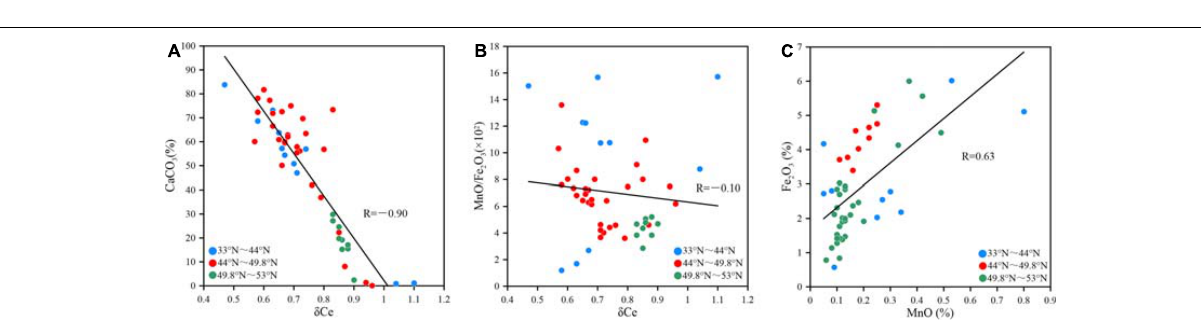
FIGURE 10 | The changing trend graph of content of three modeled grain-size end members. The spatial variation in the content of EM1 (A) , spatial variation in the content of EM2 (B) and spatial variation in the content of EM3 (C) .